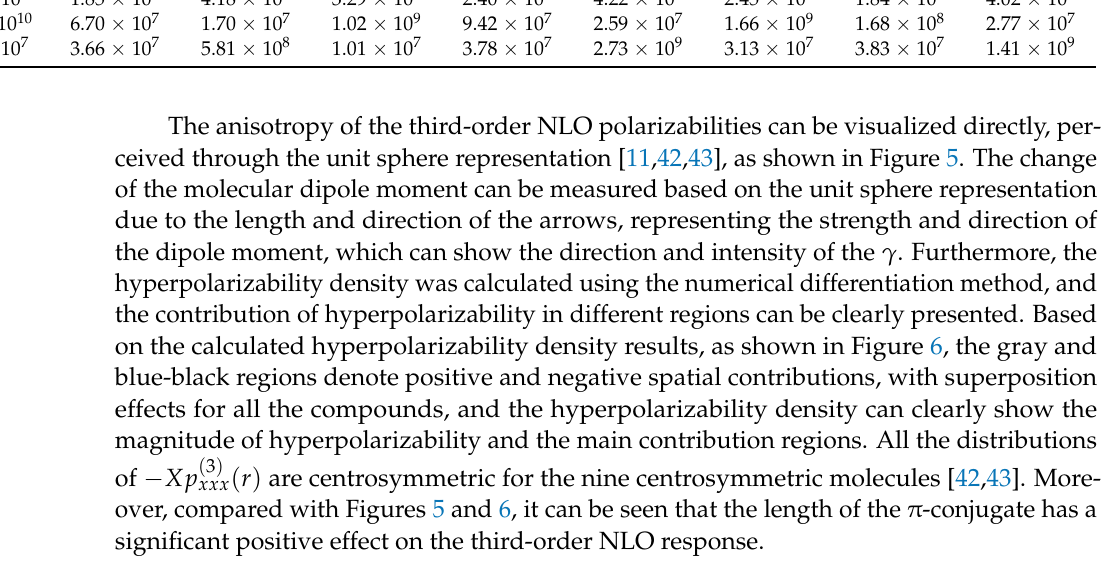
Figure 4. ( a ) Static third-order NLO coefficients ( γ ) of the compounds (1 − 9); ( b ) the relationship between the static third-order NLO polarizabilities and E gap .